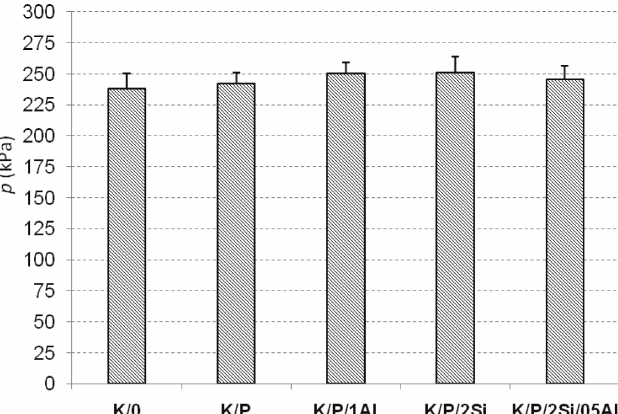
Fig. 6 – Burst strength of paperboard, PCL and PCL nano- composite coated